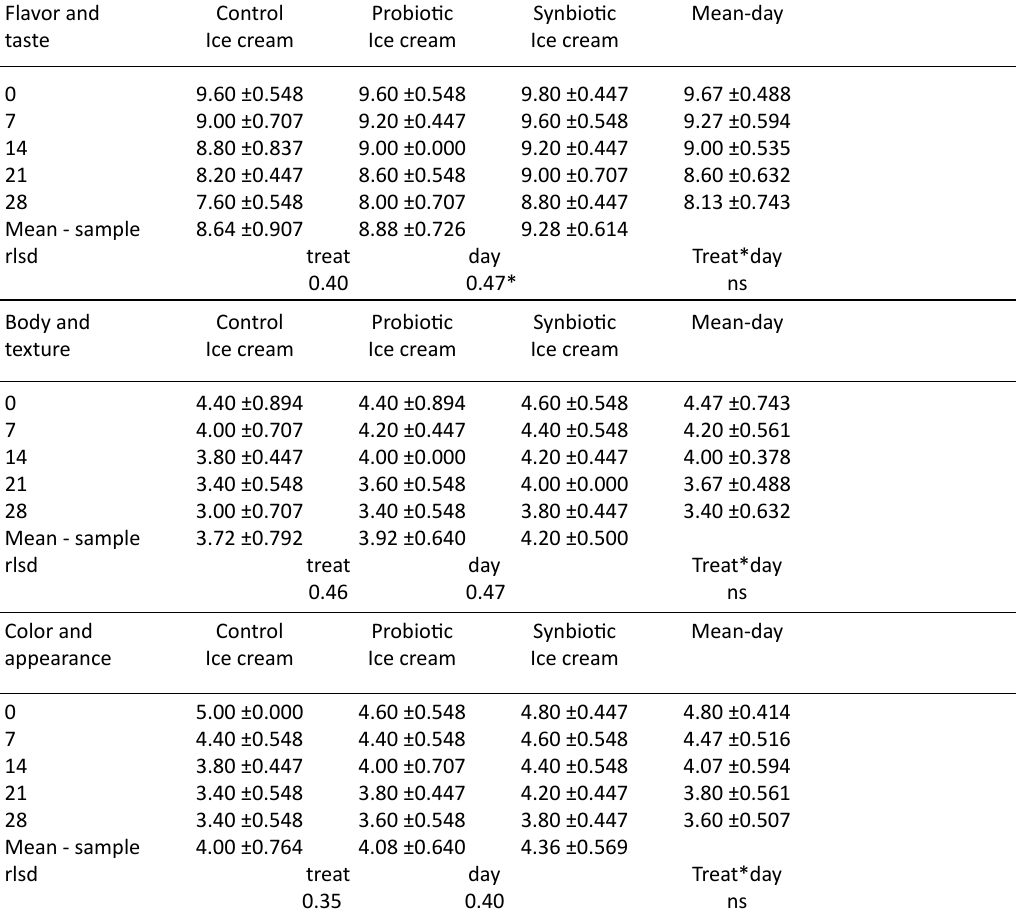
table 4. Sensory properties of control, probiotic and synbiotic ice-cream samples during storage periods Flavor